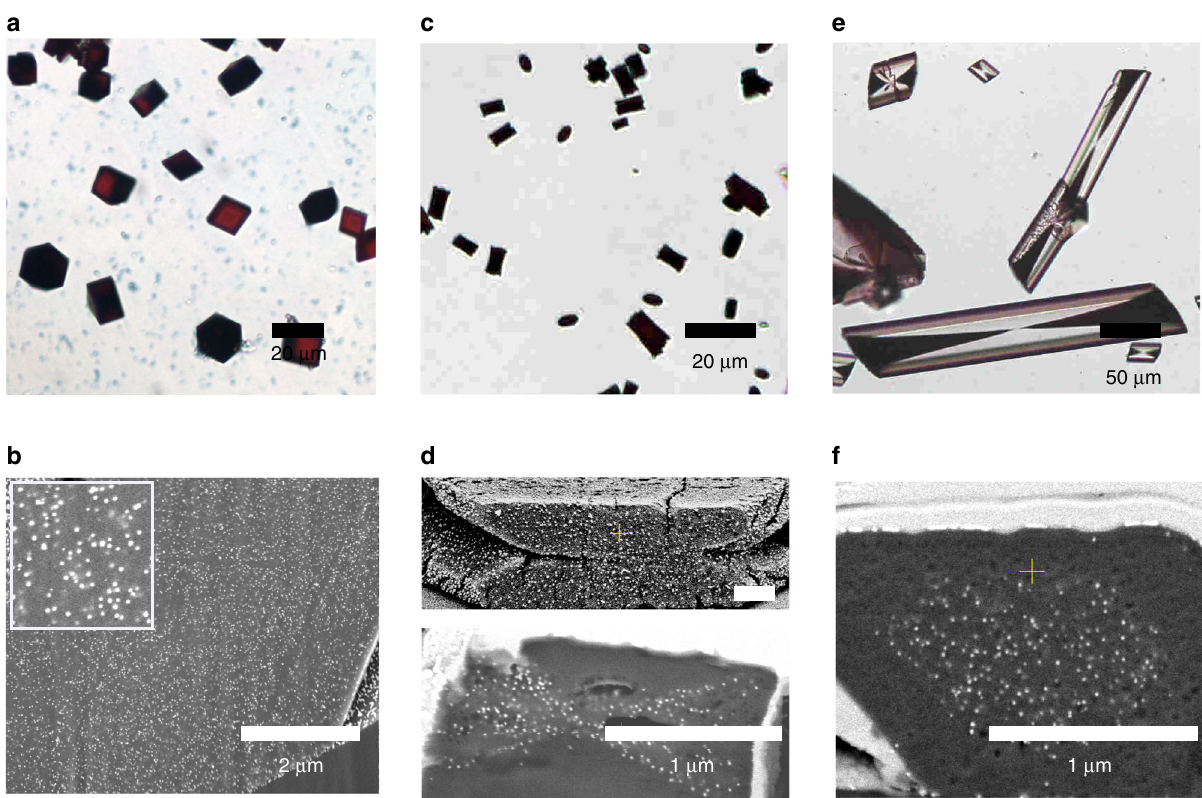
Fig. 5 Calcite, gypsum and COM crystals precipitated in the presence of hydroxyl-NPs. a , b Calcite crystals precipitated in the presence of 0.05 wt% 14 nm PVA-NPs at [Ca 2 + ] = 20 mM. c , d Calcium oxalate monohydrate (COM) crystals precipitated at [Ca 2 + ] = 0.75 mM and [Ox] = 0.75 mM in the presence of 0.01 wt% 14 nm PGMA-NPs. e , f Calcium sulfate dihydrate (gypsum) crystals precipitated at [Ca 2 + ] = 100 mM and [SO 4 2 − ] = 200 mM in the presence of 0.08 wt% 14 nm PGMA-NPs. a , c, e show optical micrographs while b , d , f are SEM images of FIB cross-sections of the